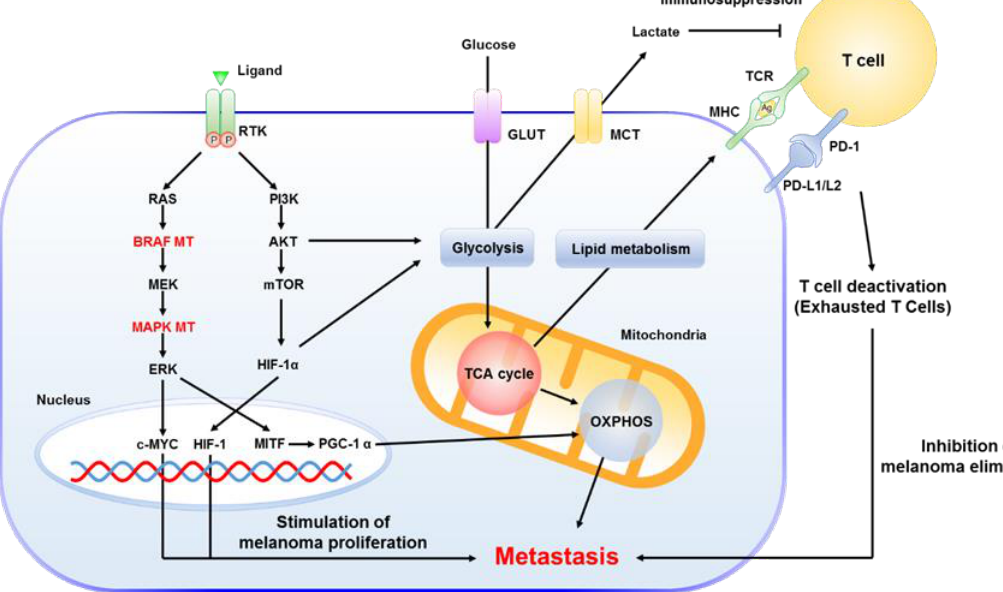
Figure 5. Metastatic melanoma. An overview of the mechanisms involved in regulation of metastases by stimulation of downstream signaling pathways through RTK activation, immunosuppression of T cells, and mitochondrial function.